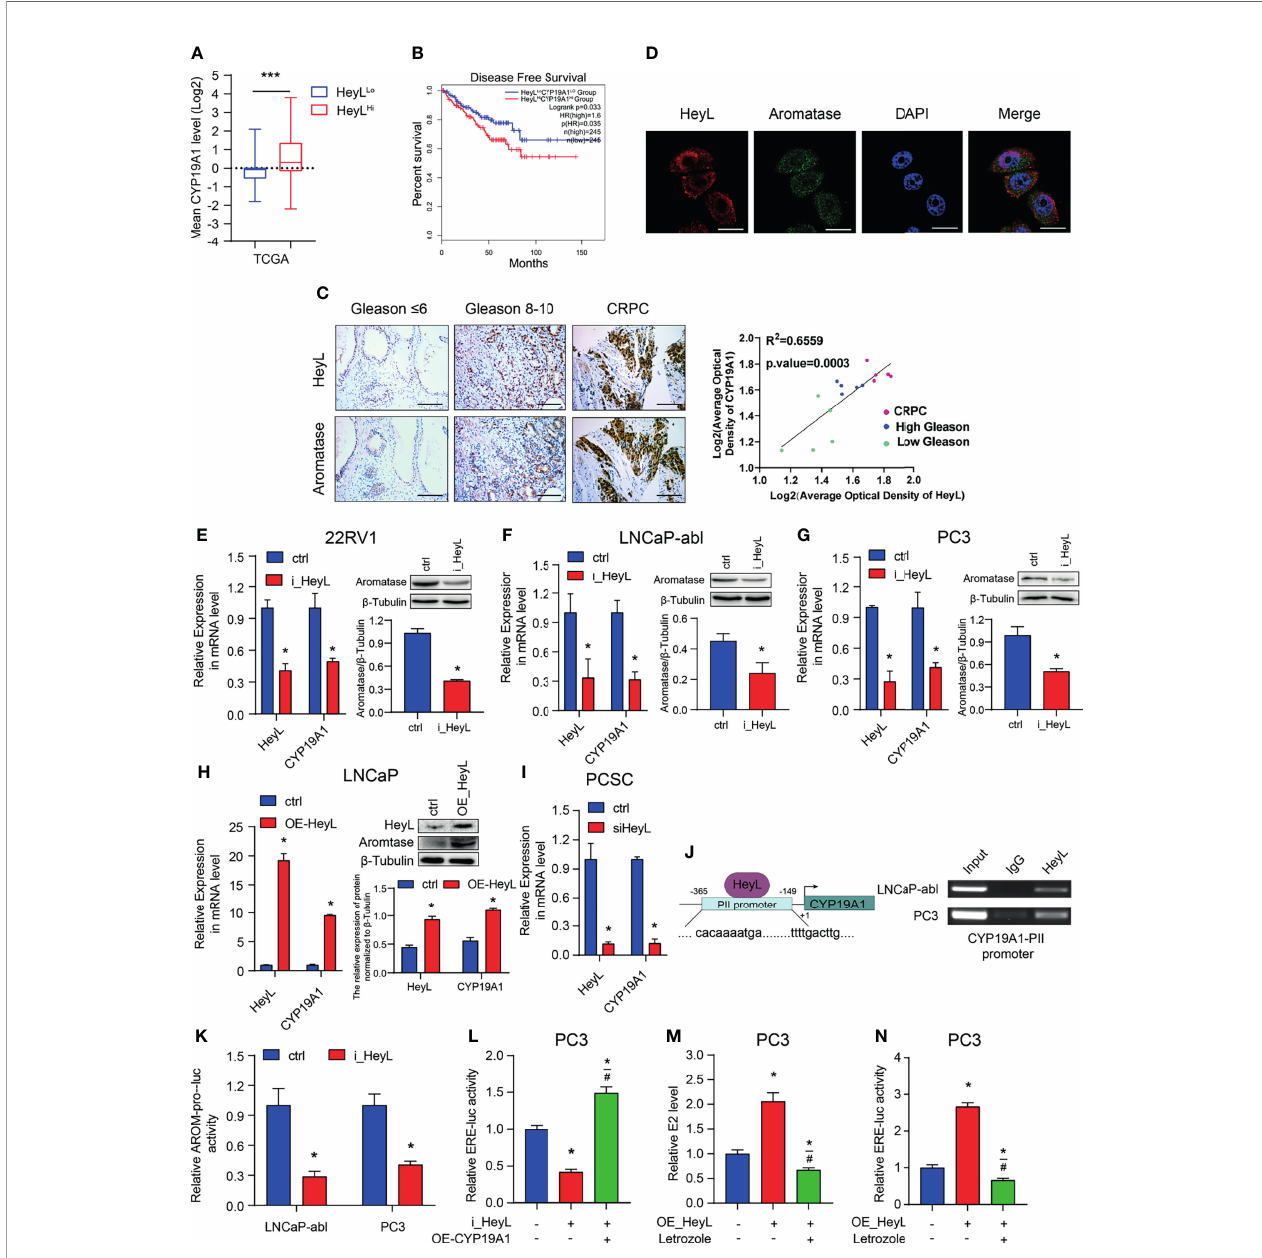
FIGURE 2 | HeyL promotes endogenous estrogenic effects by directly activating CYP19A1 transcription. (A) Mean mRNA expression levels of CYP19A1 in HeyL High samples vs. HeyL Low samples in the TCGA-PRAD dataset. (B) Kaplan-Meier analysis of disease-free survival for HeyL High CYP19A1 High patients vs. HeyL Low CYP19A1 Low patients in the TCGA-PRAD dataset. (C) Representative images of HeyL and aromatase IHC staining in low Gleason score (Gleason score ≤ 6, n=5), high Gleason score PCa (Gleason score 8-10, n=5), and CRPC (n=5) tissues. Scale bar: 100 m m. The average optical densities of HeyL and aromatase were calculated, followed by correlation analysis of HeyL and aromatase expression in primary PCa and CRPC specimens. (D) Colocalization of HeyL and aromatase in PC3 cells was detected by IF staining. Scale bar: 20 m m. (E – I) Effects of HeyL on aromatase expression. (E – G) The mRNA (left panel) and protein (right panel) levels of aromatase in 22RV1, LNCaP-abl, and PC3 cells stably transfected with control or i_HeyL were analyzed (t-test). (H) The mRNA (left panel) and protein (right panel) levels of aromatase in ctrl or HeyL-overexpressing LNCaP cells were analyzed (t-test). (I) Relative mRNA level of aromatase in PCSCs transfected with siNC or siHeyL (t-test). (J, K) HeyL directly activates CYP19A1 transcription by occupying its promoter. (J) Left: Schematic diagram of the binding site between HeyL and the promoter of CYP19A1 promoter. Right: ChIP showed that HeyL binds directly to the CYP19A1 PII promoter region. (K) Relative aromatase promoter activity (AROM- pro-Luc) in LNCaP-abl and PC3 cells stably transfected with control or i_HeyL (t-test). (L – N) Relative ERE-Luc activity (L, N) and the concentration of intracellular 17 b -estradiol (M) in PC3 cells after the indicated treatment (one-way ANOVA). PCSC, prostate cancer stem cell; ChIP, chromatin immunoprecipitation; E2, 17 b - estradiol. The data are presented as the mean ± SD values (n=3). * p < 0.05 vs. ctrl. # p < 0.05 vs. i_HeyL or OE-HeyL. ***p <